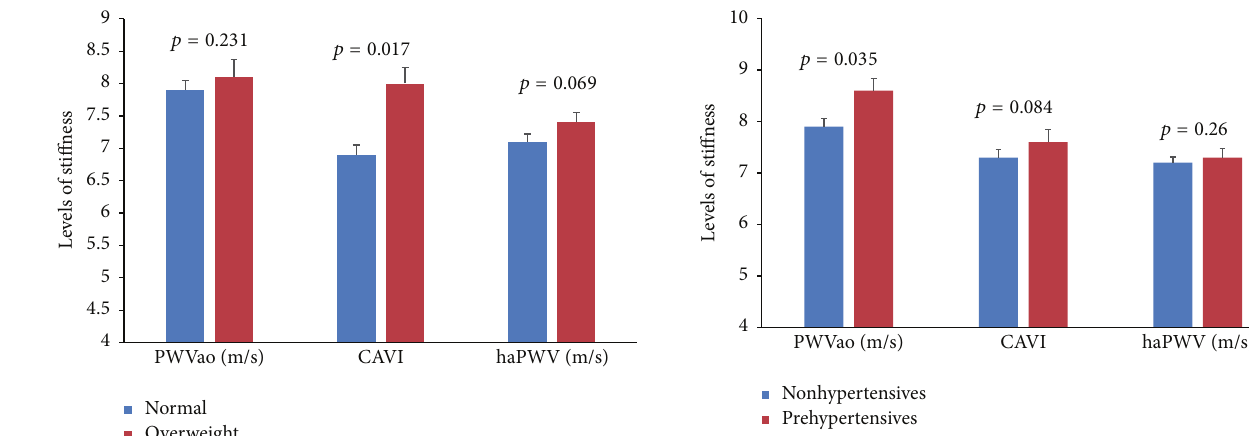
Figure 1: Comparison of arterial stiffness indices between normal and overweight participants.